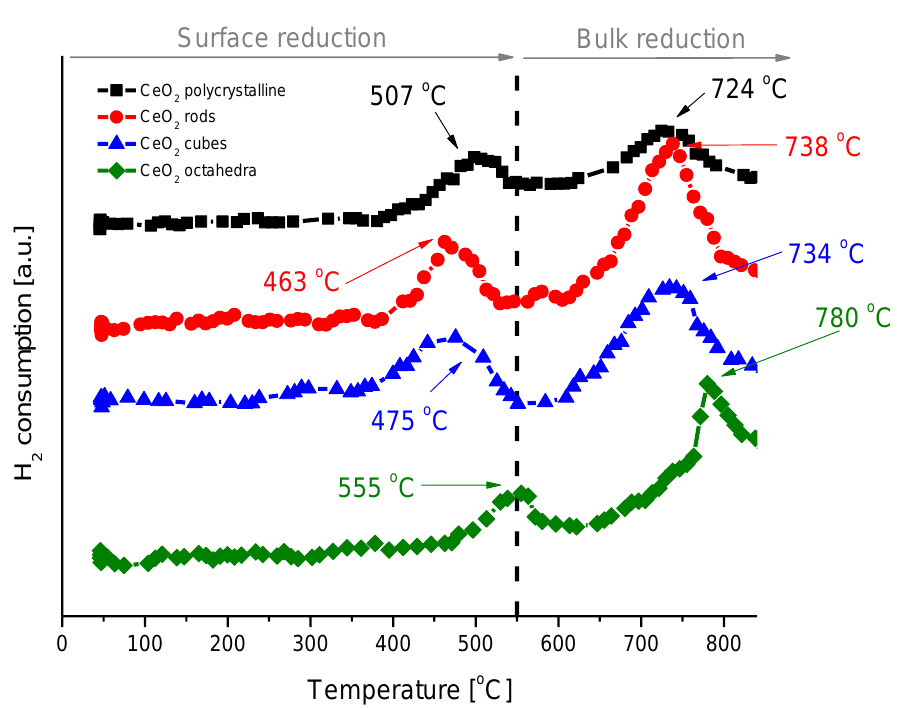
Figure 7. H 2 -TPR profiles of cerium dioxide nanoshapes. Table 3. The overall amount of hydrogen consumed in H 2 -TPR and oxygen consumed in CO 2 pulse chemisorption.